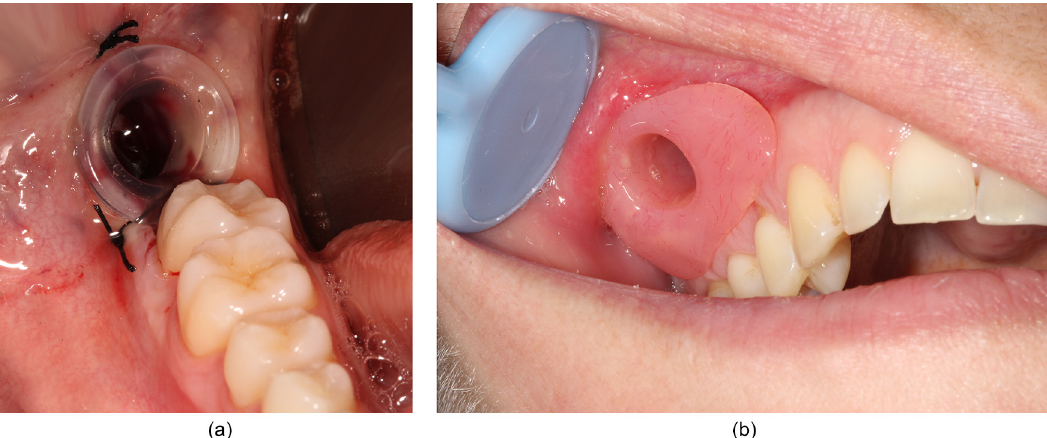
Fig. 5. Examples of decompression cannulas. (a) Thermoformed cannula in a position in line with the dental arch. This cannula has been prepared before the fi rst surgery time (cyst opening and biopsy) and installed during the intervention. Stitches concern only the surrounding mucosa to “ trap ” the drain during healing. As an option, if the tube is not fl anged, stitches can also trans fi x the drain. (b) Individual resin cannula in a case of decompression above the maxillary teeth apices. This cannula has been manufactured from an impression taken a week after the fi rst surgery time, and installed afterwards.